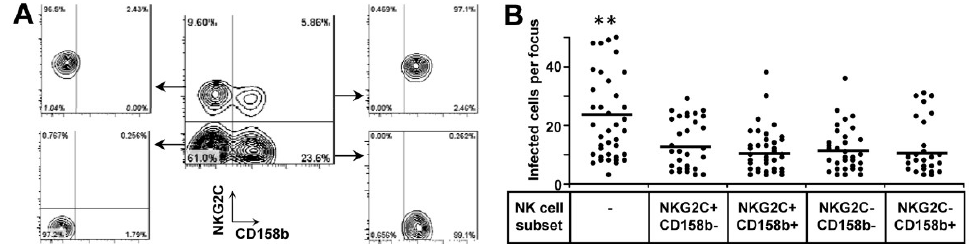
Figure 4. NKG2C + NK cells are functional to inhibit HCMV transmission. ( A ) Gating and sorting strategy. NK cells were sorted from PBMCs based on CD3, CD56, NKG2C and CD158b expression. Initial gating on forward and side scatter was used to include lymphocytes. CD3 and CD56 were used to identify NK cells. NKG2C and CD158b were used to differentiate NK subsets. ( B ) BAC4-repUL40 infected fibroblasts were co-cultured with 2000-fold uninfected fibroblasts for 3 days. Four sorted NK subsets were added to the focus expansion assay settings at an E:T ratio of 0.25. Monolayers were fixed and infected cells were monitored by HCMV IEA staining. Dots represent mean values of infected cells per focus. Bars indicate mean values. ** indicates p < 0.05 to all other groups.